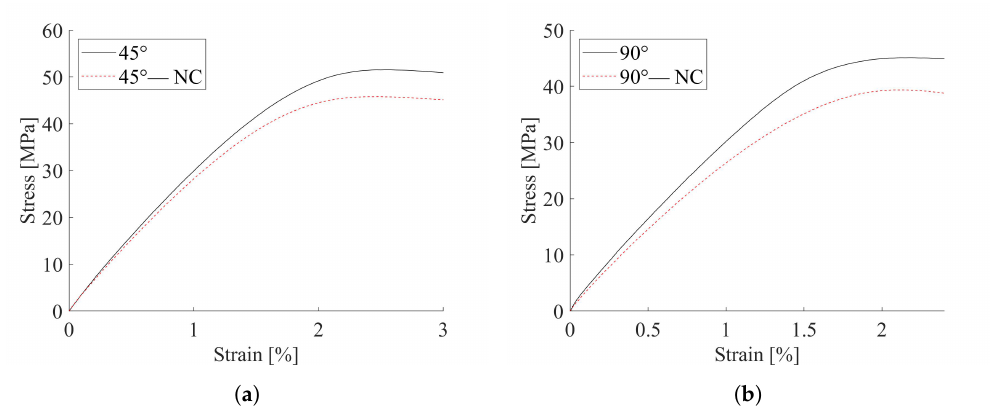
Figure 3. Contoured vs. not contoured specimens tensile curves; ( a ) 45° infill orientation; ( b ) 90° infill orientation.